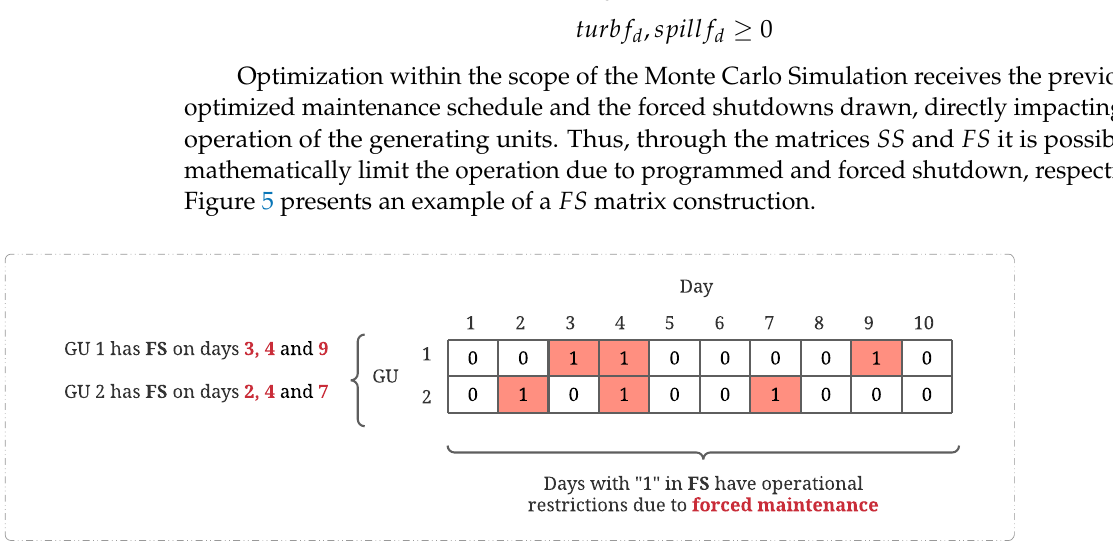
Figure 5. Example for Formulation of Forced Shutdown (FS)